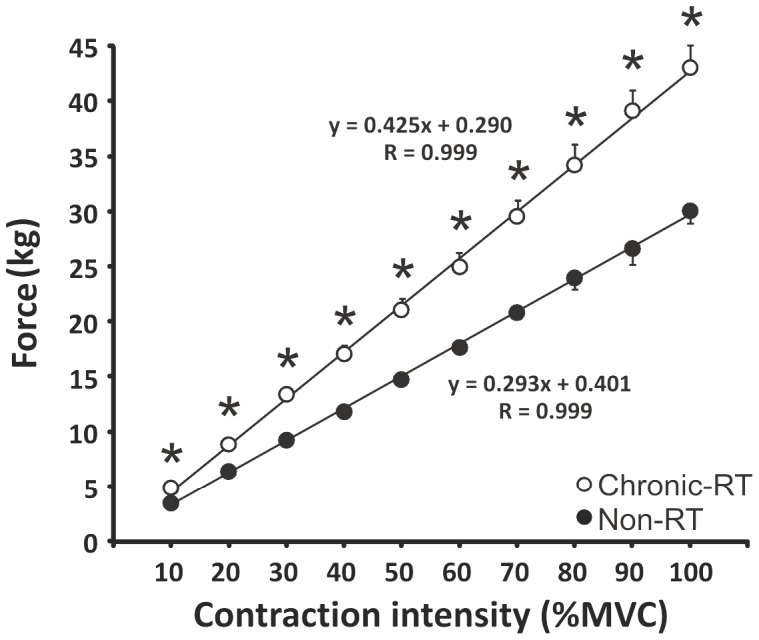
Elbow flexion force over all contraction intensities.Absolute-relative target force relationship of the elbow flexors. The slopes and r values are illustrated for each group. Each data point represents the group means ± SE. * Indicates significant (p≤0.032) differences between groups.